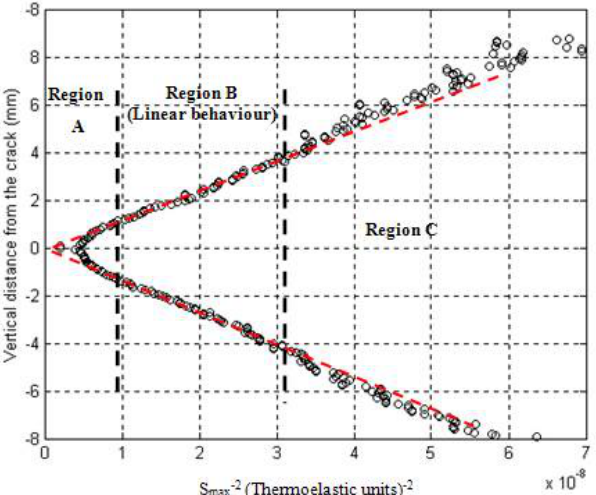
Figure 3: Graph of showing the linear relationship between the vertical distance from the crack tip and (S max ) -2 employed in the methodology of Stanley and Chan for the calculation of the stress intensity factor from thermoelastic data. Based on previous analyses, the region of validity for the model is identified in (Figure 3) as the portion of the graph where a linear relationship is observed (Region B). Consequently, data is collected from the corresponding region of the thermoelastic image where such a linear relationship in Stanley’s plot exists. The collected points are used to fit the stress field equation described by Muskhelishvili’s model and to reconstruct the stress field around the crack tip. From the resultant fitting equation the SIF can be inferred (figure